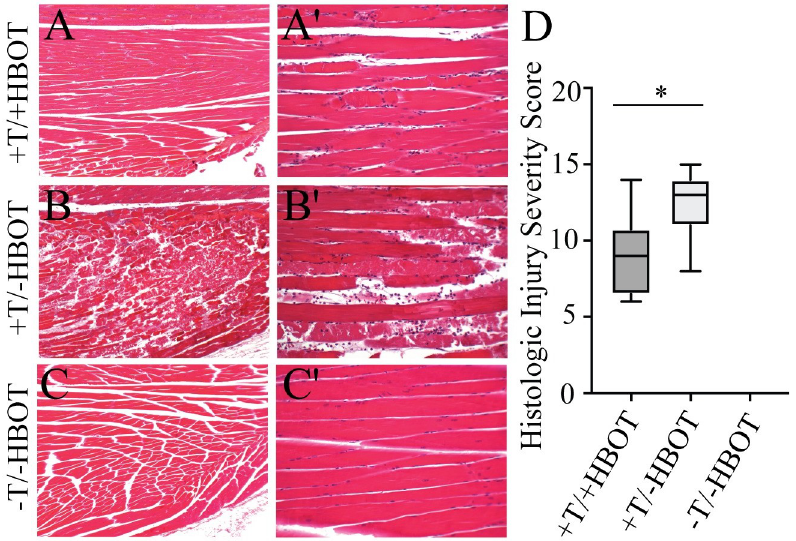
Fig 4. Neutrophil elastase activity and intracellular hypoxia in injured tissue treated with hyperbaric oxygen (HBO). H&E staining (40X) of tissue samples from +T/+HBO, +T/-HBO, and -T/-HBO (control tissue) muscle samples, taken 48 hours after treatment shows that tissue quality is markedly increased in A) tissue from mice that received HBO treatment, as compared to B) tissue from mice that received no treatment. C) Tissue from control mice that did not receive either a tourniquet or HBO treatment are shown for comparison. A’-C’) H&E staining (100X) of tissue samples. D) Histologic Injury Severity Scores. Box and whisker plot shows highest and lowest HISS score, as well as quartile